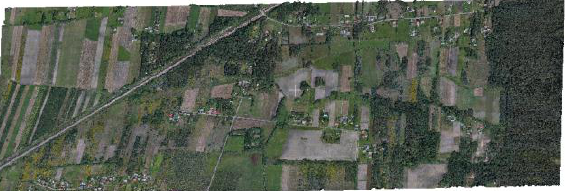
Figure 5. Point Cloud generated from low quality images (poor weather condition)